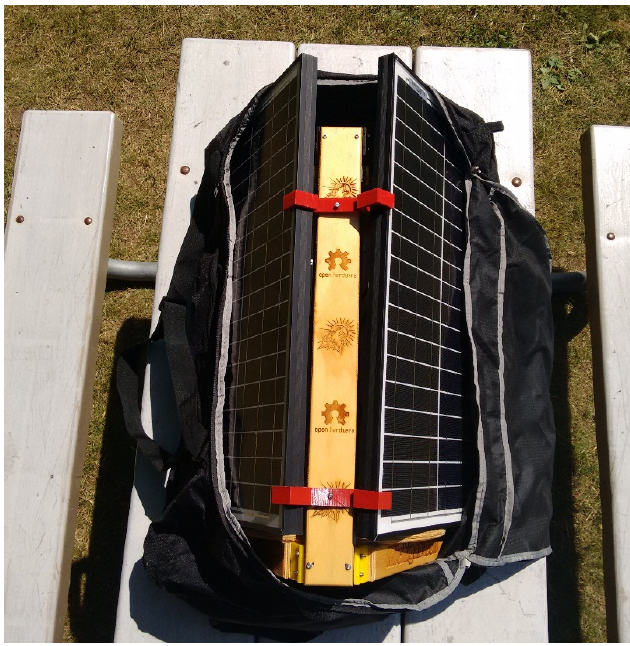
Figure 8. Photograph of the MOST-delta 3D printer and PV stand-alone power system assembly in transit in a duffel bag. For transportation the modules are mounted on all three sides of the delta.